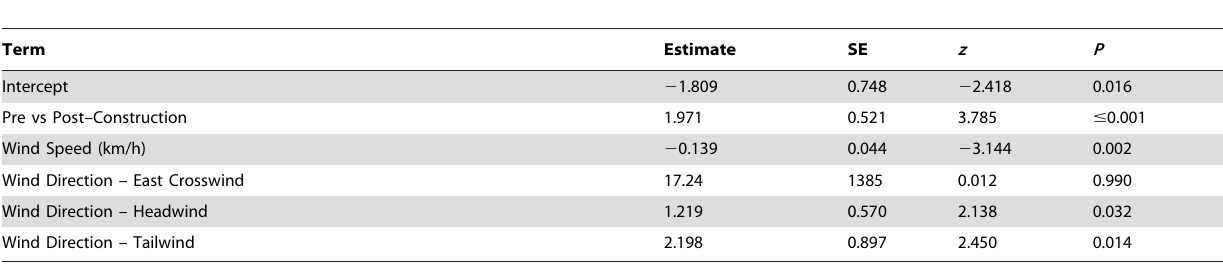
Table 2. Summary of logistic regression examining the association of temporal and environmental variables on the likelihood of flying over the ridge-top area (100 m buffer around proposed turbine string) at rotor swept height (risk zone; # 150 m above